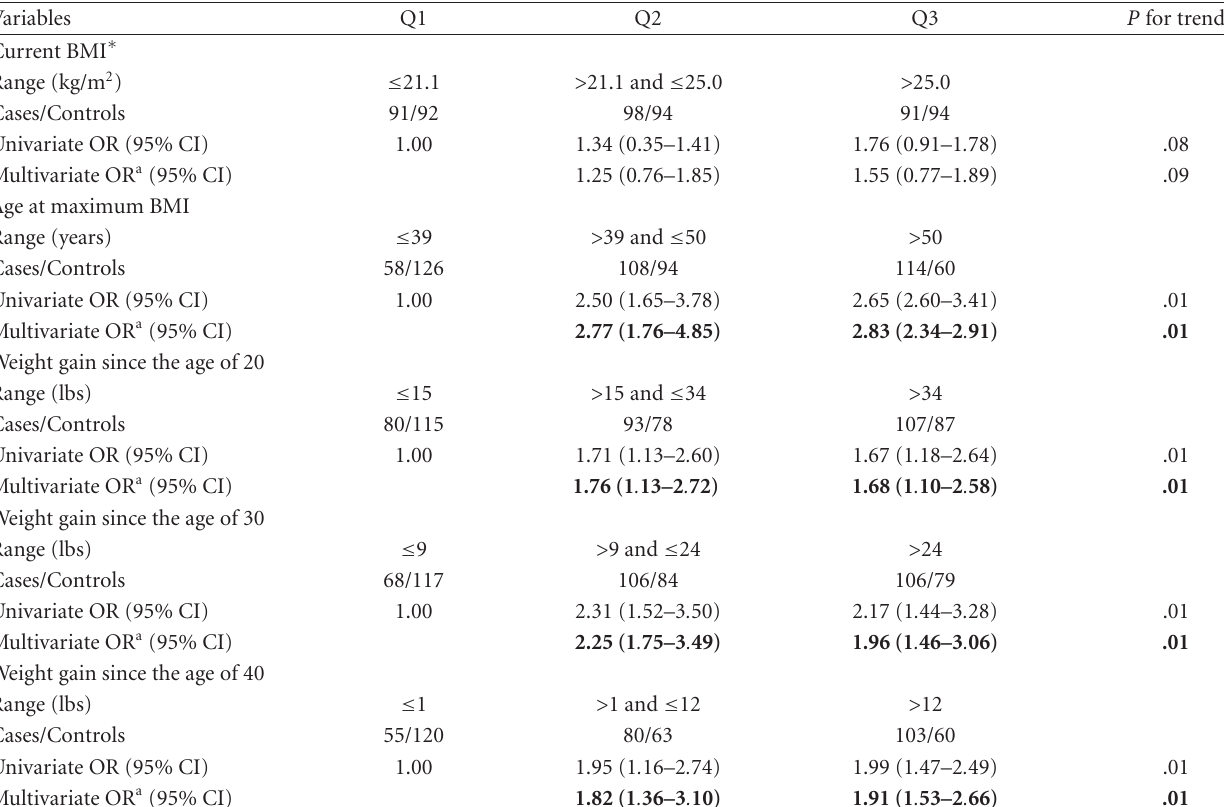
Table 2: Odd ratios and 95% confidence intervals for breast cancer risk associated with weight